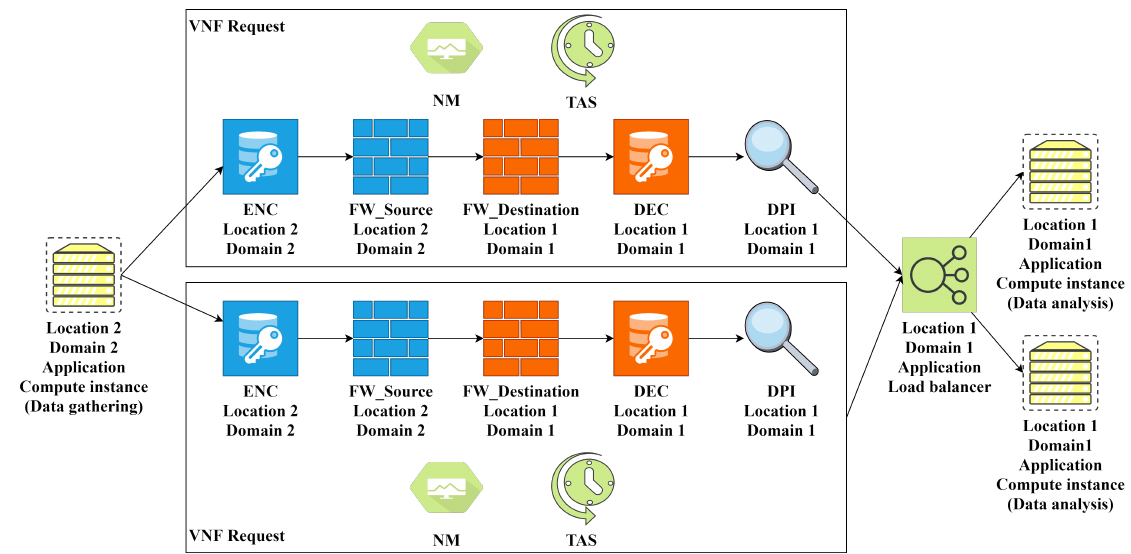
Figure 6. Generated EVN for AR11.